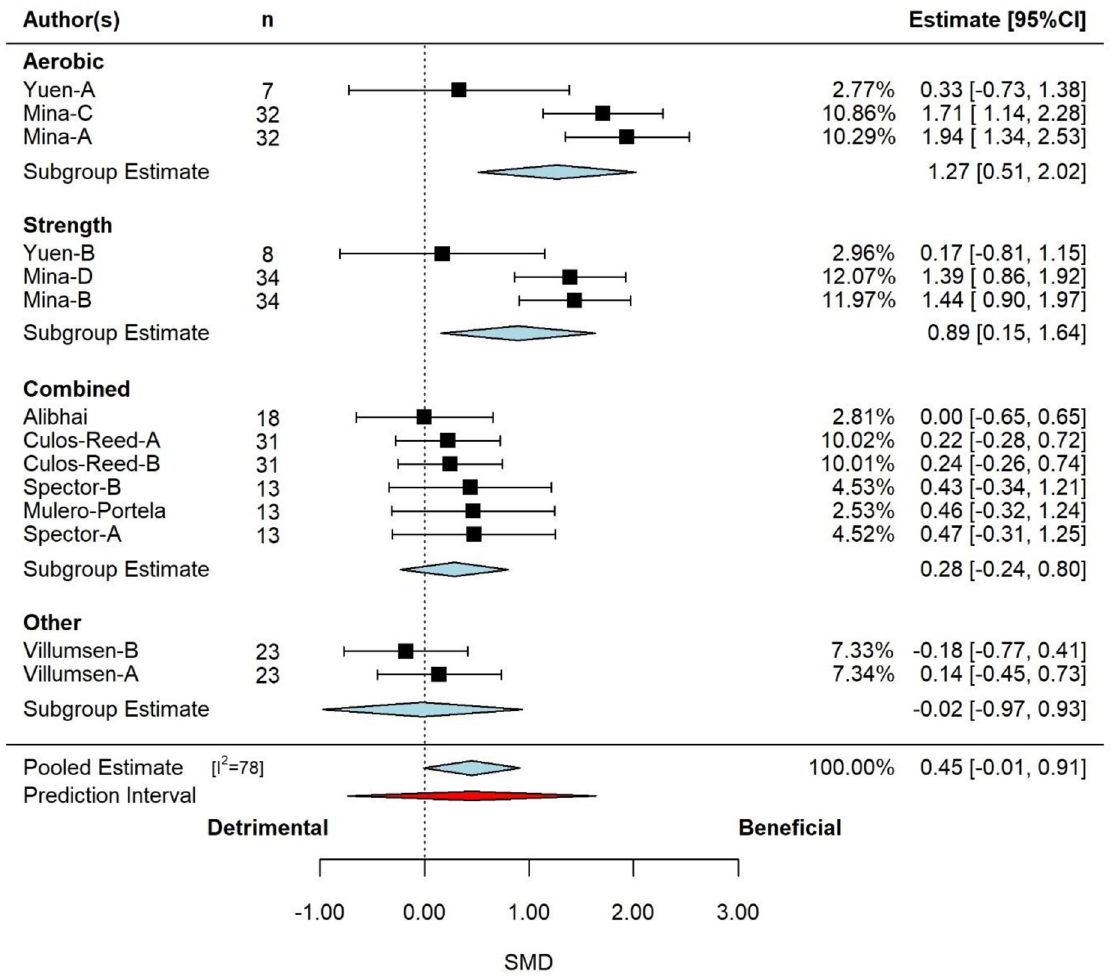
Fig 4. Pooled effect of exercise intervention on cardiorespiratory fitness, with sub-group analysis by exercise intervention type (k = 7, u = 14, n = 312). Based on the 3-level model, there was a small effect (SMD = 0.45, 95% CI: -0.01 to 0.91) which approached significance ( p = 0.056). Abbreviations : CI, confidence interval; SMD, standardized mean